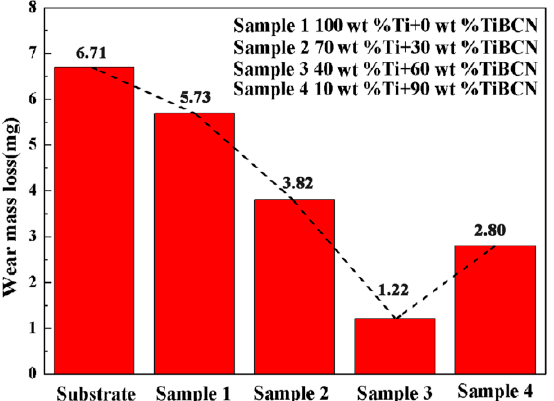
Figure 7. Friction coefficient of the substrate and Ti/TiBCN composite coatings with the different TiBCN contents.